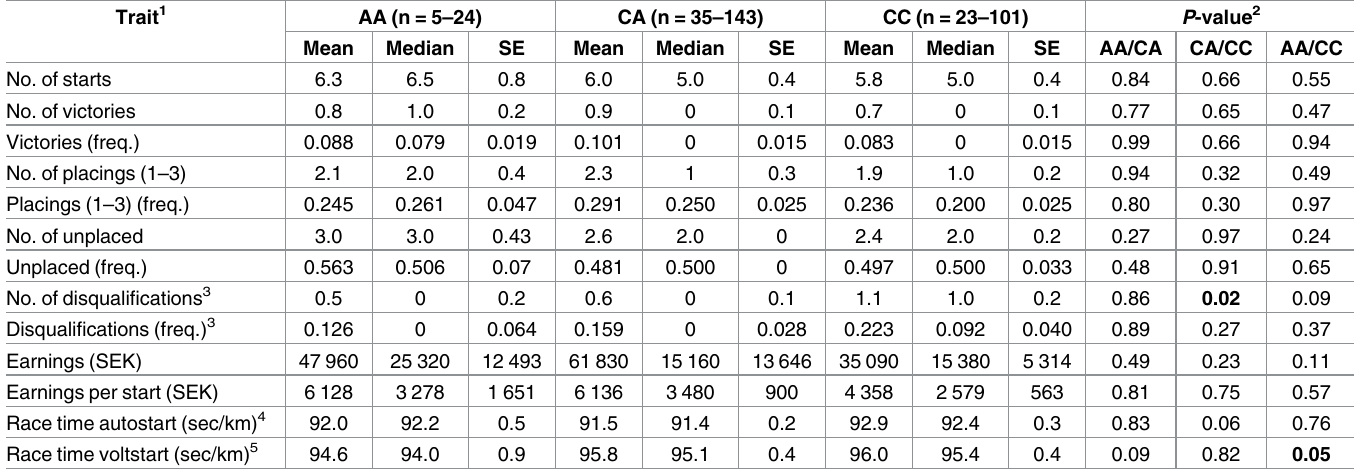
Table 2. Mean and median racing performance results for Coldblooded trotters at 3 years of age according to DMRT3 genotype (n = 268). Trait